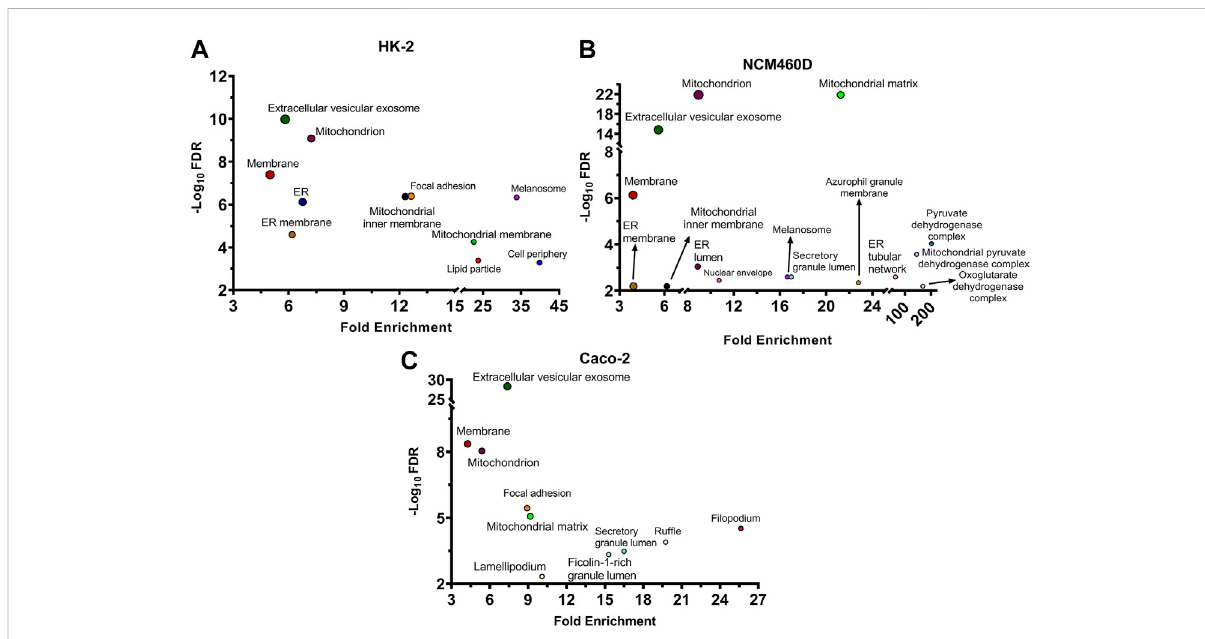
FIGURE 2 Cellularcomponentsanalysisofallidenti fi edS1interactorsbasedonGeneOntologydatabase.Foreachenrichedterm,thebubbleplotdisplays the -Log10 FDR versus the fold enrichment value for HK-2 (A) , NCM460D (B) , and Caco-2 (C) cell lines. FDR: False Discovery